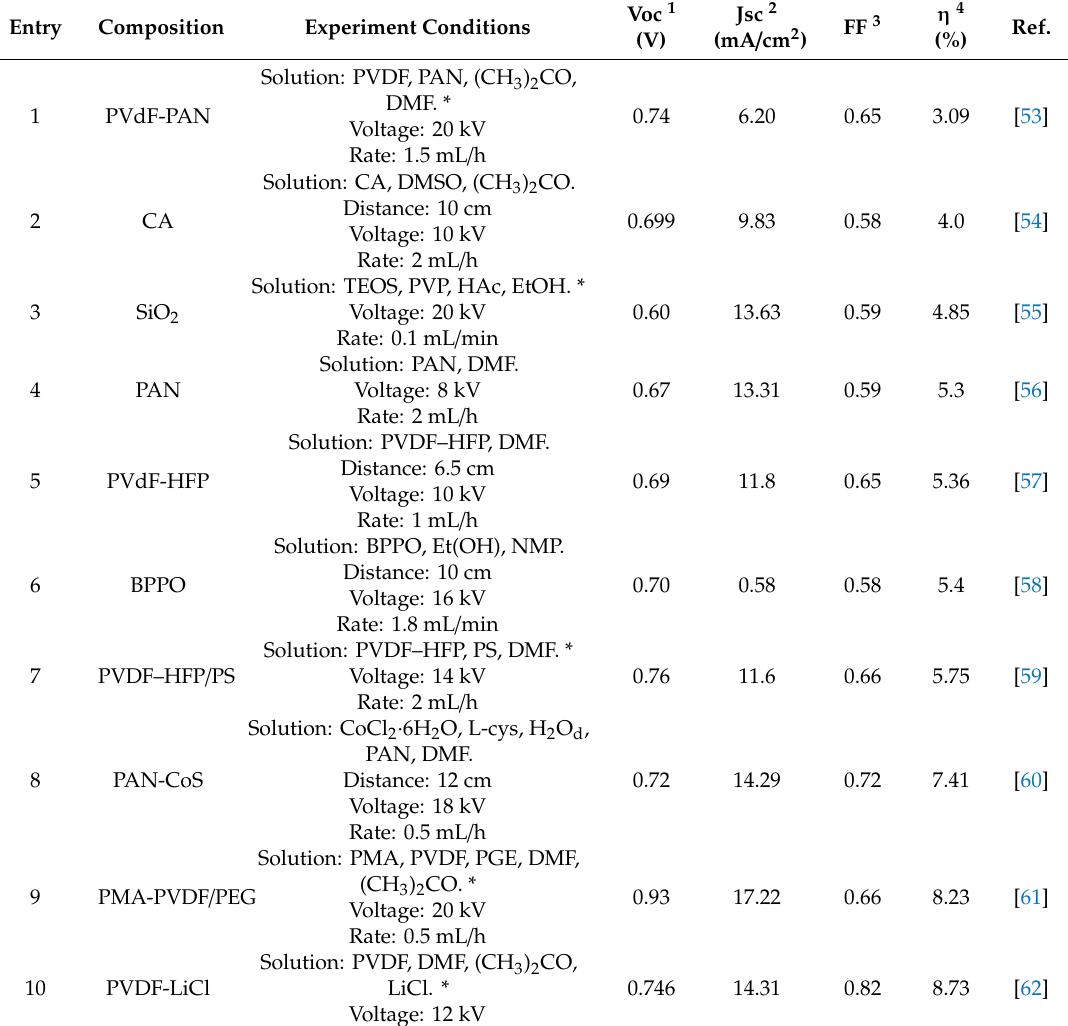
Table 3. Comparison of the characteristics of electrospun nanofibers for